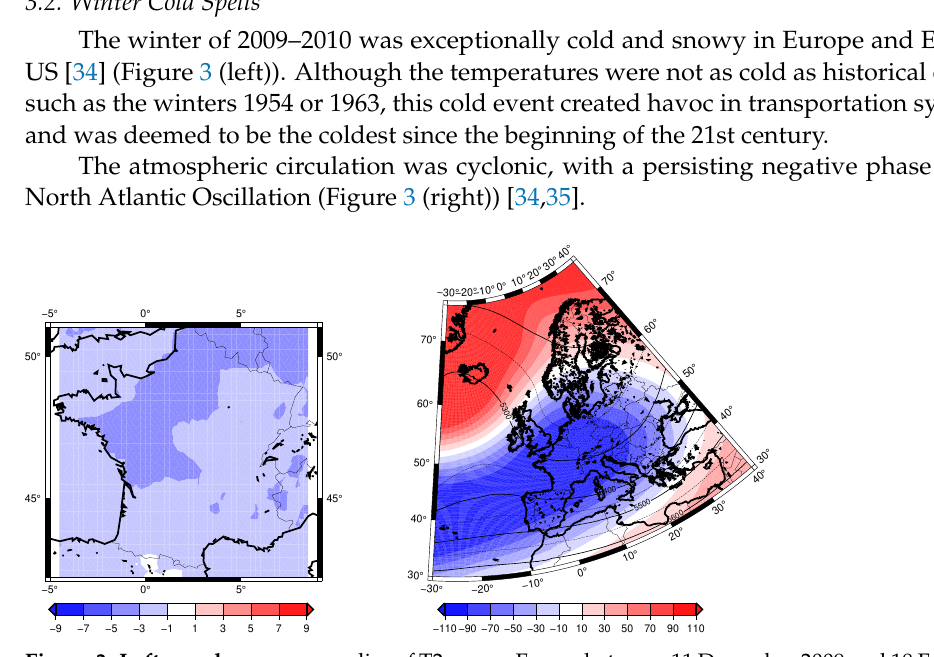
Figure 3. Left panel : mean anomalies of T2m over France between 11 December 2009 and 18 February 2010. Right panel : mean anomalies of (in m) over the East North Atlantic region (colours). Contour lines indicate the mean Z500 (in